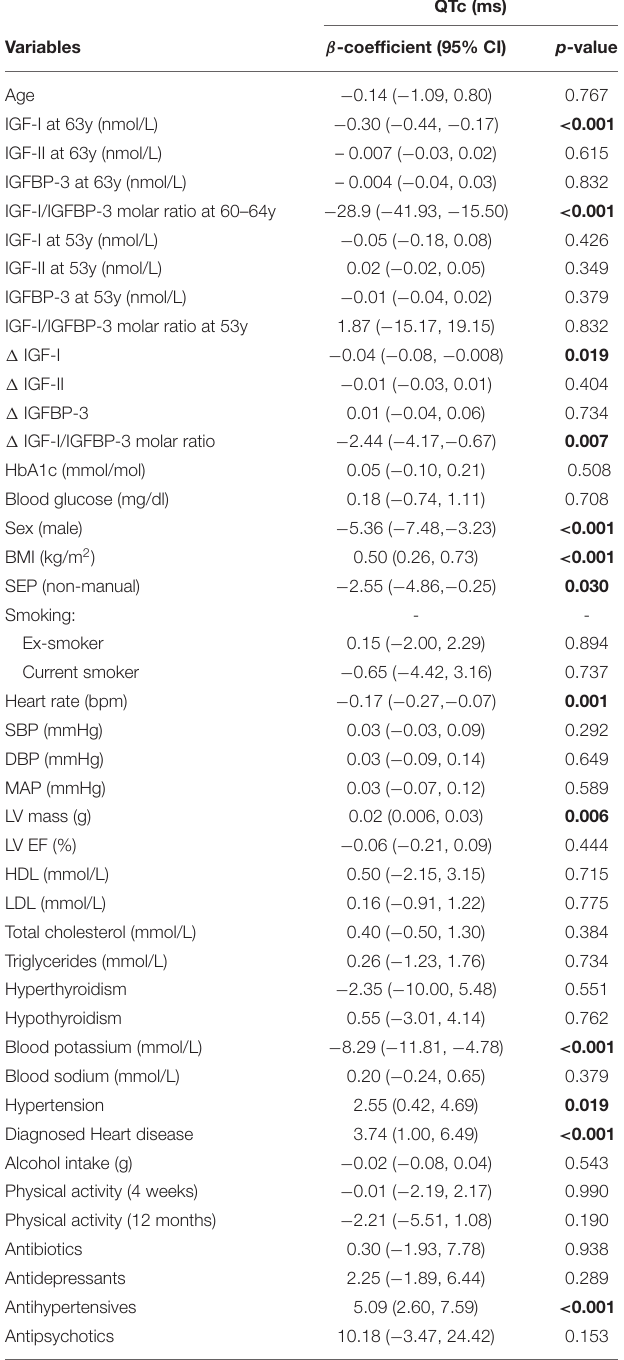
Based on these multiple imputation models, independent associations with QTc were also confirmed for other previously known covariates: female sex ( β 9.65 [6.65, 12.65] p < 0.001), increased left ventricular mass ( β 0.04 ms/g [0.02, 0.06] p